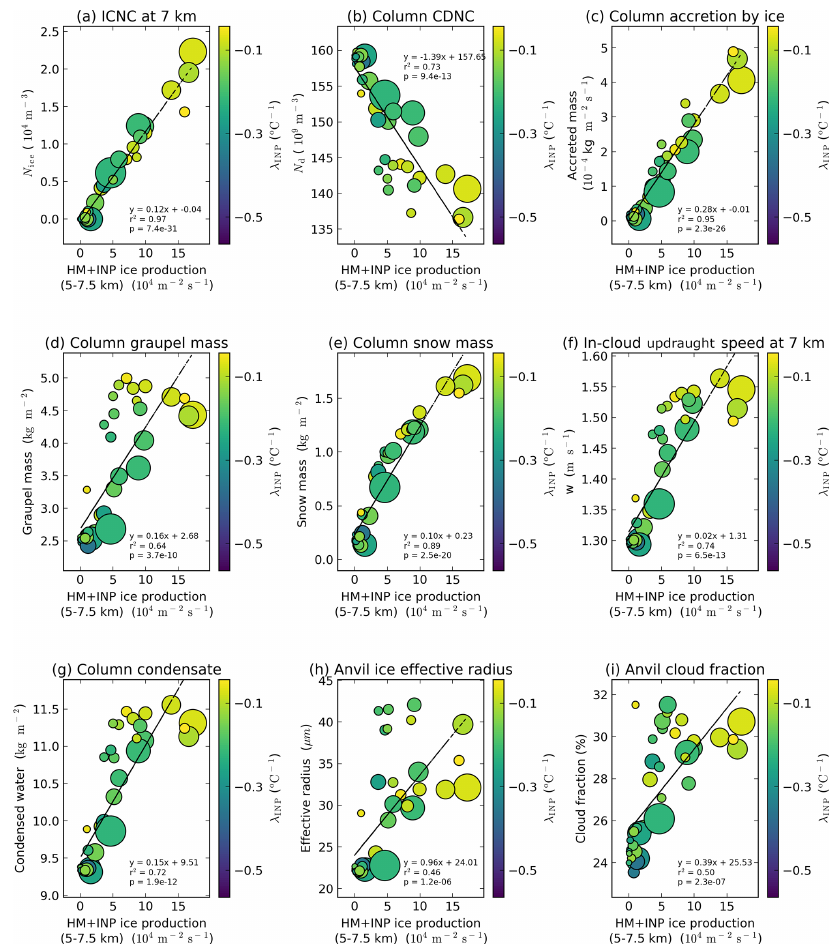
Figure 14. Importance of ice production in the Hallett–Mossop ice production regime (5–7.5km). Dependence of cloud properties on ice particle production in the Hallett–Mossop regime (5–7.5km) in the convective stage of cloud development (60–180min). Shown is ICNC at 7km (a) ; column cloud droplet number concentration (b) ; accretion of water by ice (c) ; graupel mass (d) ; snow mass (e) ; in-cloud updraught speed at 7km (f) ; cloud condensate from cloud droplets, rain, ice crystals, snow, and graupel (g) ; anvil ice crystal effective radius at 14km (h) ; and anvil cloud fraction (i) . The colour of the markers indicates λ INP and the marker size indicates the HM-eff. Panels (a) – (g) are the average of the cloud property between 60 and 180min (convective stage) of the simulation, while panels (h) – (i) are the average of the relevant cloud property between 150 and 240min (anvil stage) of the simulation. Simulations deemed as having unrealistically high or unrealistically low INP concentrations due to the combined perturbations of λ INP and N INP − 38 (as indicated in Fig. 5) are not shown in this plot or included in the correlation